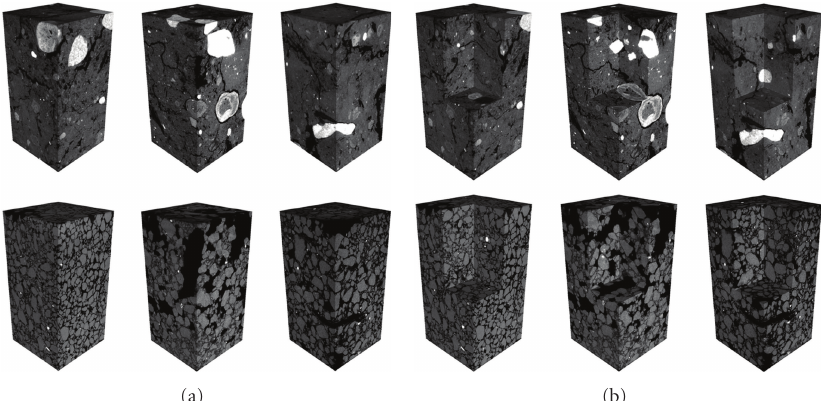
Figure 5: Scanned soil samples. PBI samples are on the bottom and JBP samples are on the top. A) complete scanned sample, B) internal view of scanned sample.